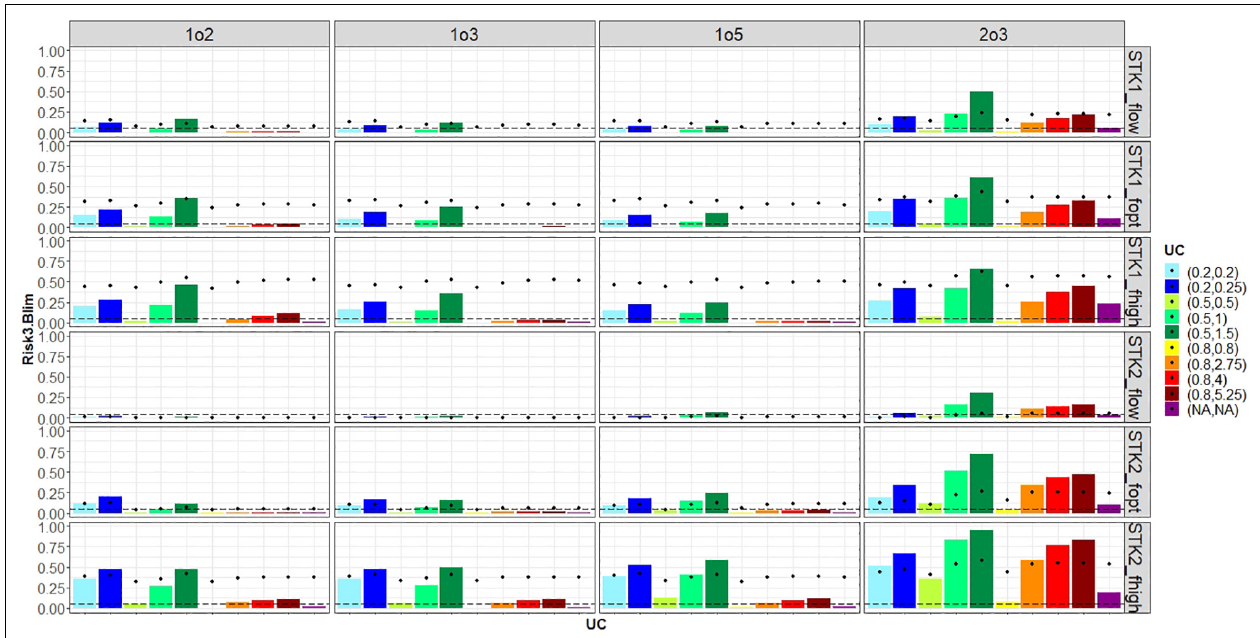
FIGURE 5 | Biological risks (Risk3.Blim: maximum probability of falling below B lim ) for the different configurations of the rule in an in-year advice. The rows correspond to the operating models (combination of stock type and the historical exploitation level) and the columns to the harvest control rule type. The uncertainty cap lower and upper limits combinations are represented on the x-axis for alternative timeframes: the black dots represent the risks in the short-term (first 5 projection years) and the colour bars represent the risk in the long-term (last 10 projection years). The horizontal dashed line corresponds to the 0.05 risk. See Table 1 for definitions of abbreviations. Interactive version of the figure is available online at https://aztigps.shinyapps.io/Sanchezetal2021_FMS/.